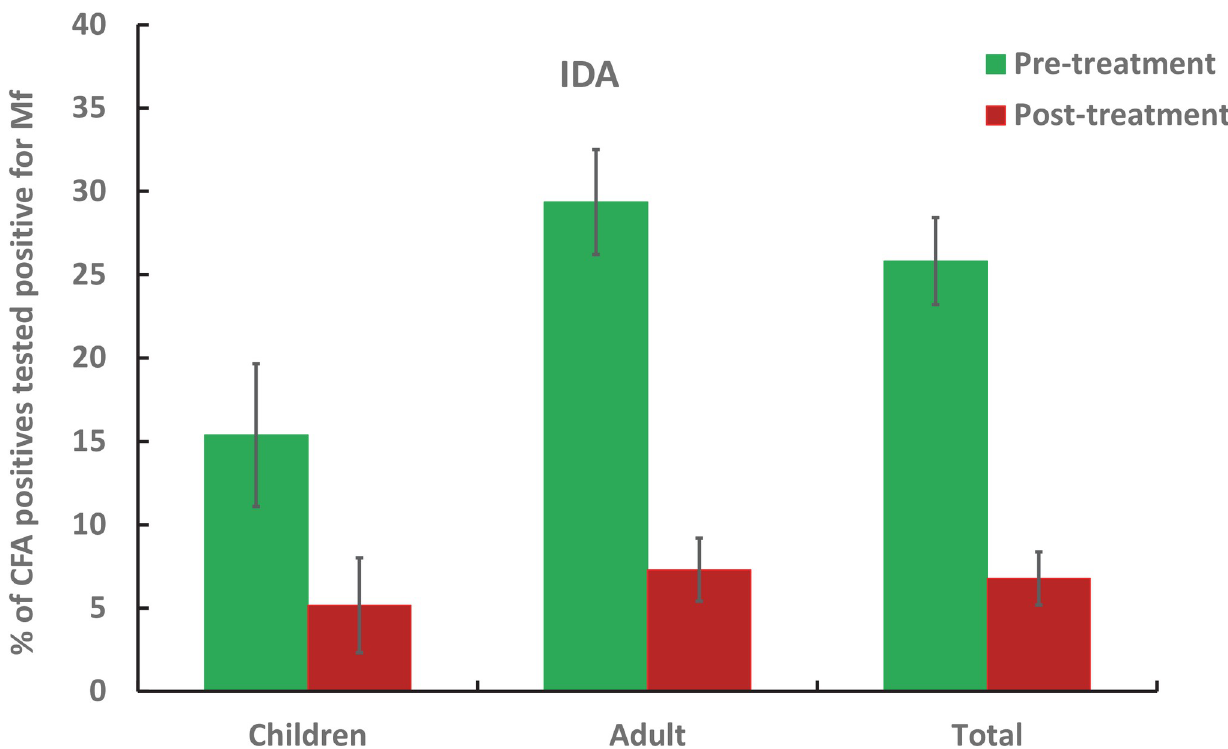
Fig 7. Percentage of CFA positives tested positive for Mf prior to and 1-year post treatment with IDA in children, adult and for all ages.